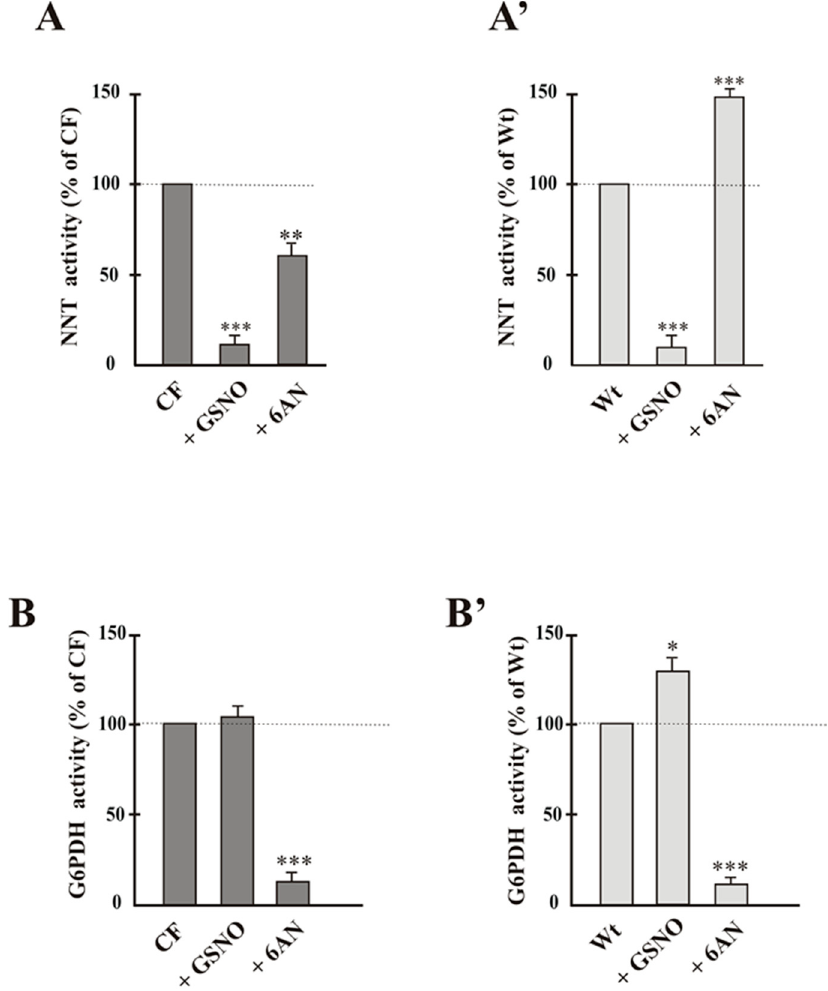
Figure 3. NNT ( A - A’ ) and G6PDH ( B - B’ ) activities in the presence of own and the specific inhibitor of the other enzyme. Values were subjected to statistical analysis (Wt, n = 5; CF, n = 4). Each value was expressed as % of control, i.e., sample in the absence of compound, to which value 100 was given. * p < 0.05; ** p < 0.01; *** p < 0.001 when comparing untreated cells with the cells in the presence